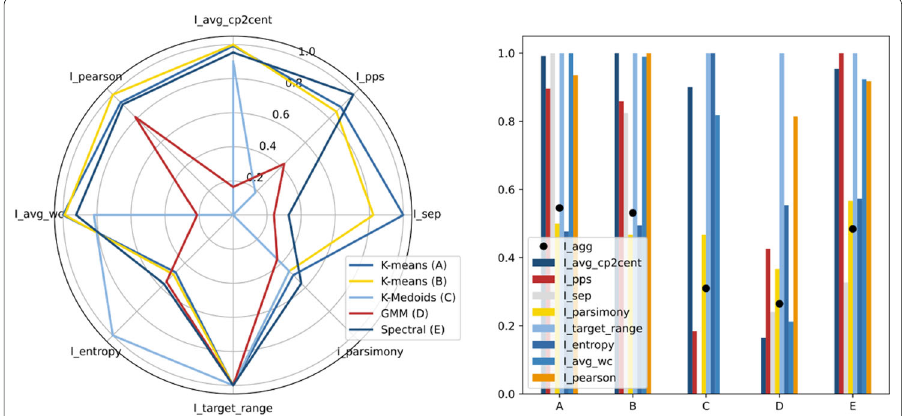
Fig. 3 Cluster validation indices for